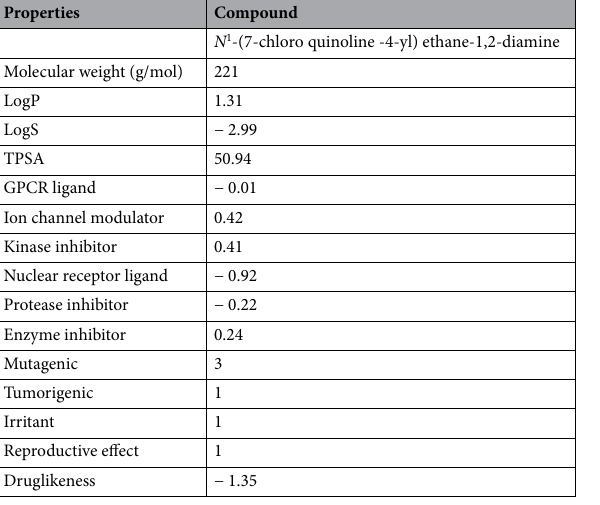
Table 1. Informatic analysis results using Osiris (https:// www. organ ic- chemi stry. org/ prog/ peo/) and Molinspiration (https:// www. molin spira tion. com, Slovensky Grob, Slovakia) software. The toxicity risk is expressed considering the following number code: (1) no risk (2) medium risk (3) high